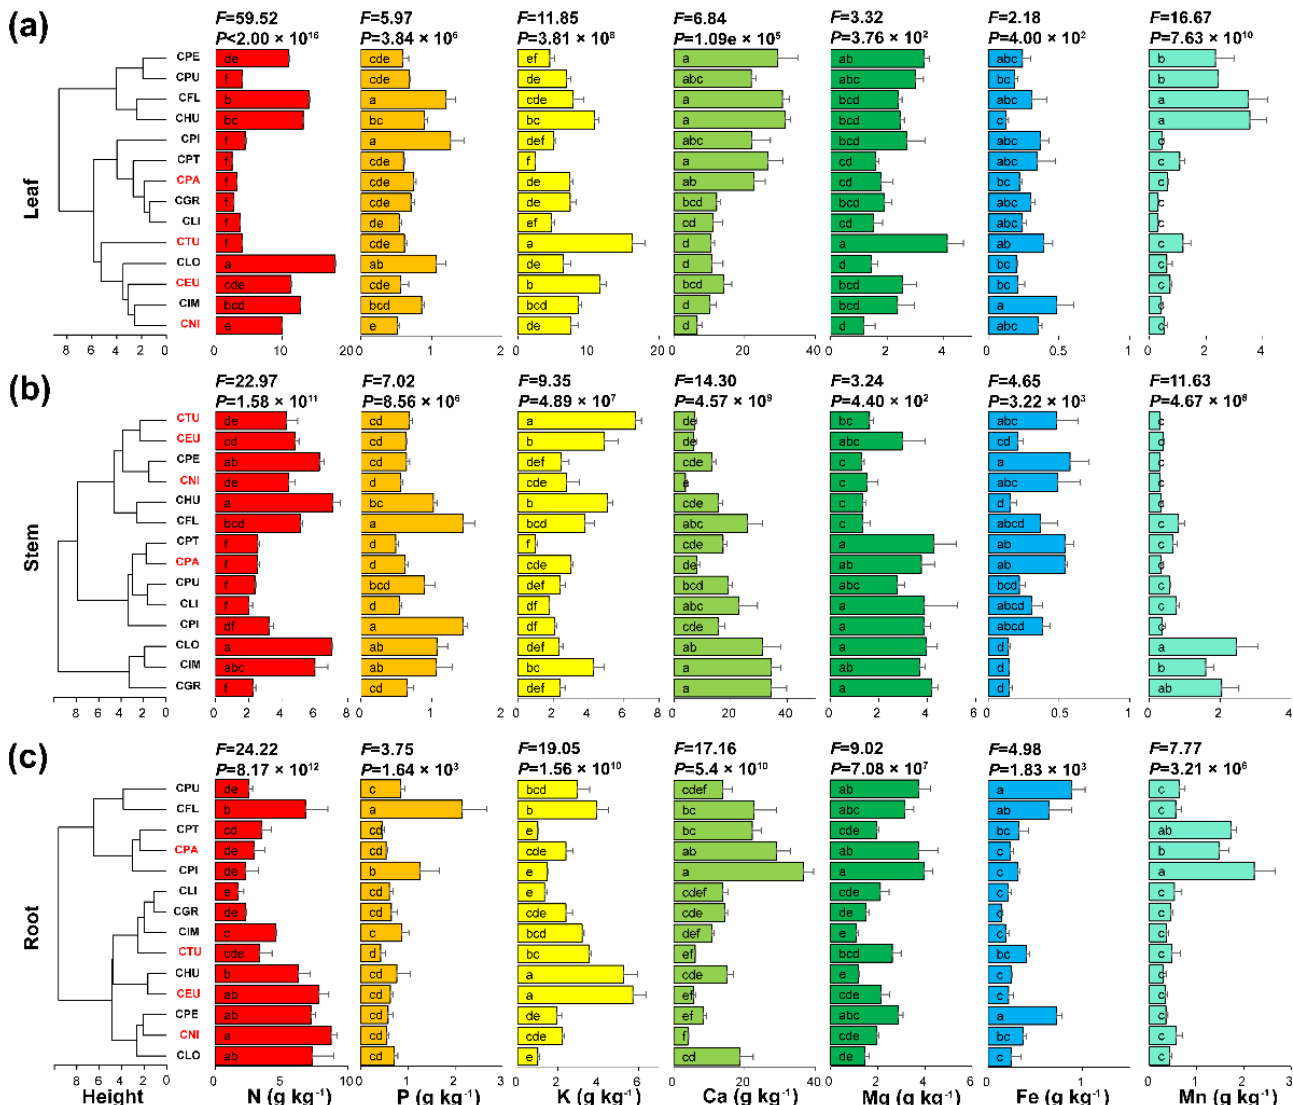
Figure 3. Comparison of the N, P, K, Ca, Mg, Fe, and Mn contents among leaves ( a ), stems ( b ), and roots ( c ) of 14 golden Camellia species. The black and red species labels at the ends of the clustering trees represent CSC and ASC, respectively. F and P are the statistics and significance of the ANOVA, respectively. The lines in the bar chart represent the standard deviation. Different letters indicate significant differences ( p < 0.05) according to Duncan’s multiple comparison test.